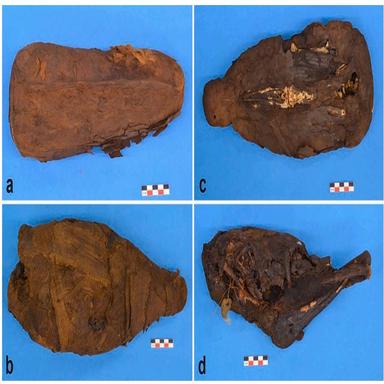
Photographs of the 4 ibis mummies of the Mus´ee des Confluences: (a) MHNL 90002472; (b) MHNL 90002475; (c) MHNL 90002486; (d) MHNL 90002491 (© Program MAHES).